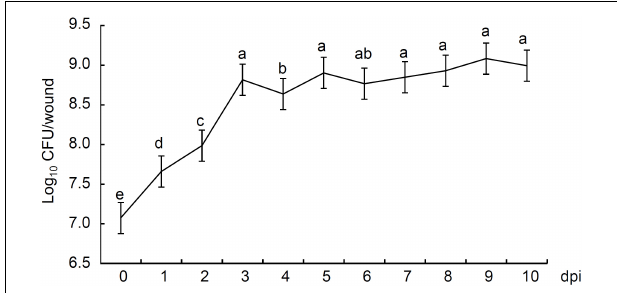
FIGURE 6 | Population dynamics of B. velezensis strain P2-1 in wounds of apple fruit. The colonies were counted and population densities were expressed as log 10 CFU/wound. Each data represents the mean ± SD of three biological replicates. Different letters indicate significant differences between different treatments according to Student’s t -test ( P < 0.05).